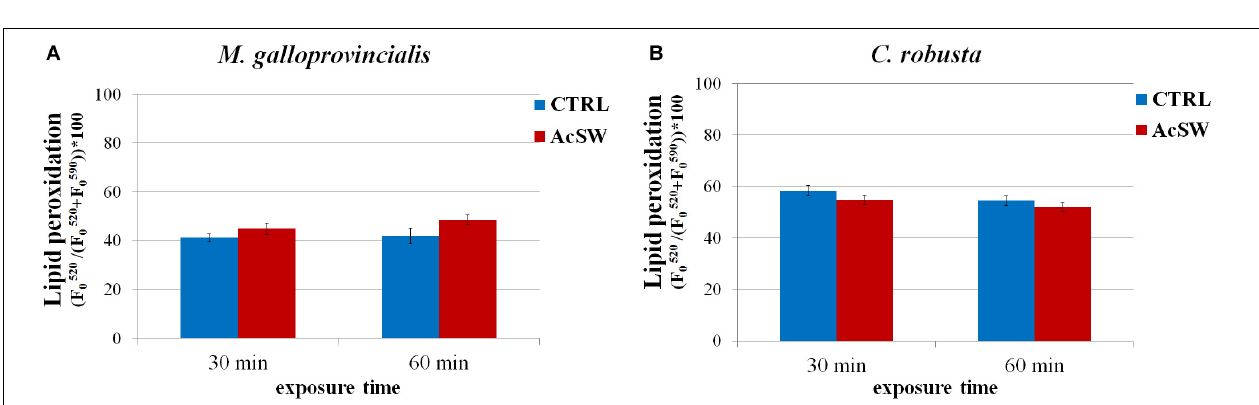
FIGURE 3 | Effects of acidified seawater (AcSW) on intracellular levels of reactive oxygen species in spermatozoa of M. galloprovincialis and C. robusta . After exposure for 30 and 60 min to filtered natural seawater with a pH value of 8.1 (CTRL) and to AcSW with a pH value of 7.8, intracellular level of hydrogen peroxide (H 2 O 2 ) (A,C) were measured at emission wavelength of ∼ 530 nm using 488 nm excitation wavelength and superoxide anion (O 2 − ) (B,D) recording fluorescent emission spectra from 600 to 650 nm after excitation at ∼ 350 nm wavelength.